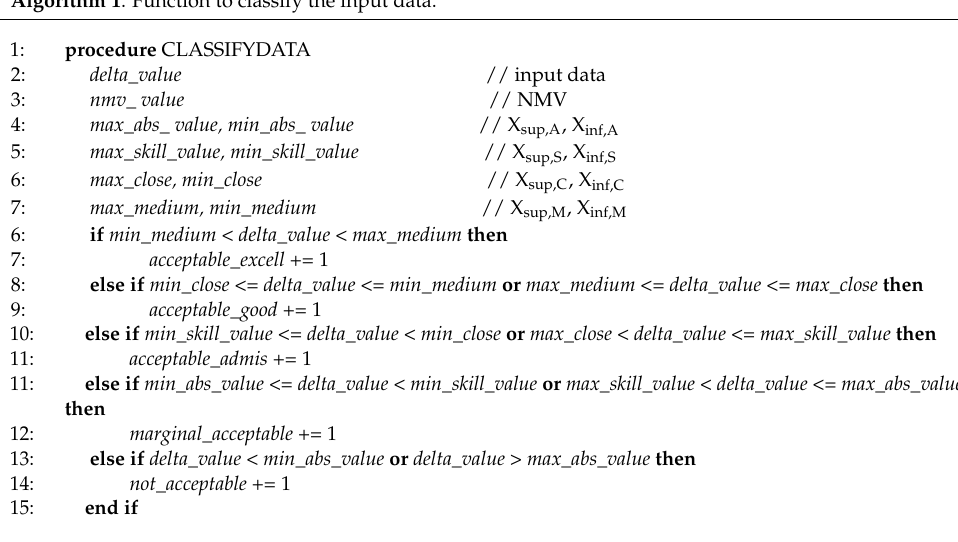
Algorithm 1 . Function to classify the input data.